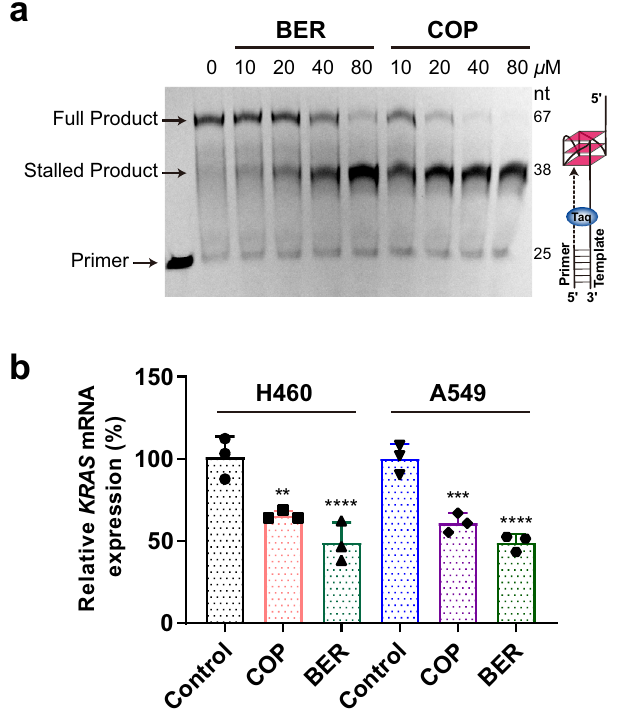
Fig. 7 | Functional characterization of KRAS -G4. a Taq DNA polymerase stop assay using a DNA template containing a wt human KRAS -G4 forming sequence shows that berberine and coptisine can stabilize the KRAS -G4 for replication inhi- bition. b qRT-PCR results show that berberine (24 µ M) and coptisine (10 µ M) lower KRAS mRNAlevelsinbothH460andA549cancercellsfor24h.DMSO(<0.1%)was used as the negative control (no inhibition, 100%). The relative KRAS mRNA levels were normalized with GAPDH . The experiments were run in triplicate. Data are presented as mean values±SD. P values (** P <0.01, *** P <0.001, **** P <0.0001) were determined by one-way ANOVA with post hoc Dunnett, relative to DMSO